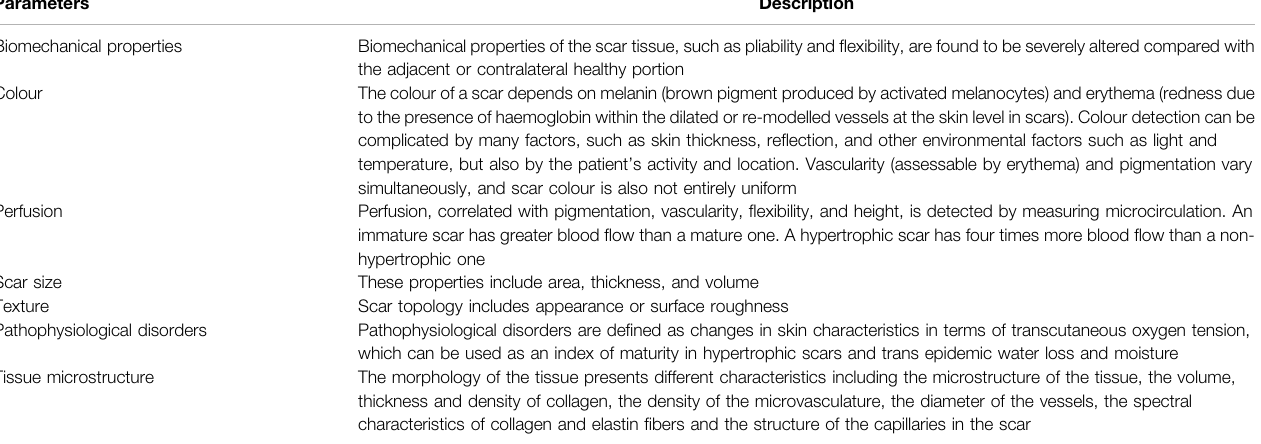
TABLE 1 | objective assessment parameters for evaluation of health state of a scar.